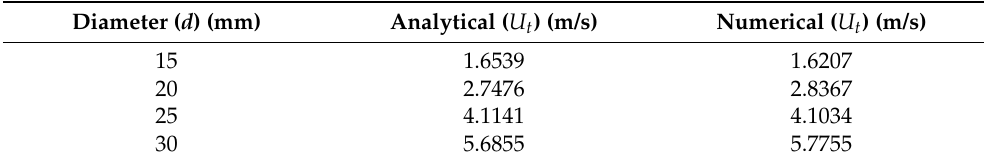
Table 2. Comparison study between the analytical and numerical estimations of the threshold wind speed of the